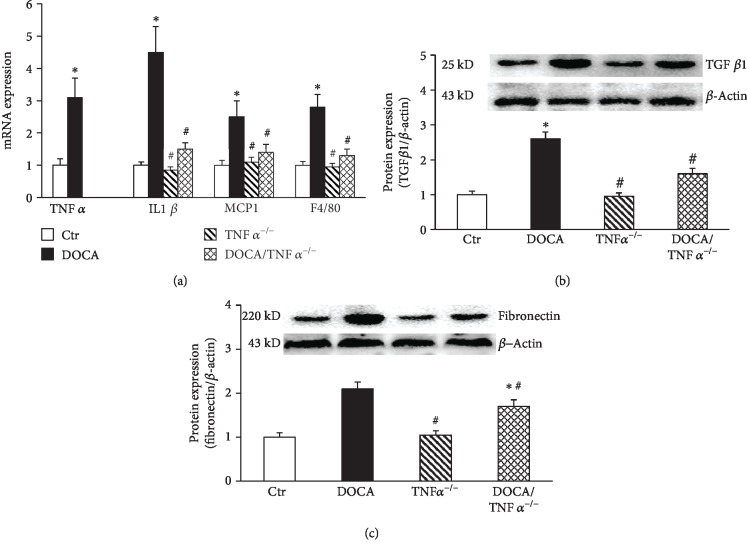
TNFα deficiency inhibited the expressions of the proinflammatory genes in the aorta of DOCA/salt-hypertensive mice. (a) The mRNA expression of proinflammatory genes including TNFα, IL1β, MCP-1, and F4/80 determined by real-time PCR (N = 6); the protein expression of fibrotic factors TGFβ1 (b, N = 6) and fibronectin (c, N = 6). ∗p < 0.05, vs. the Ctr group; #p < 0.05, vs. the DOCA group.